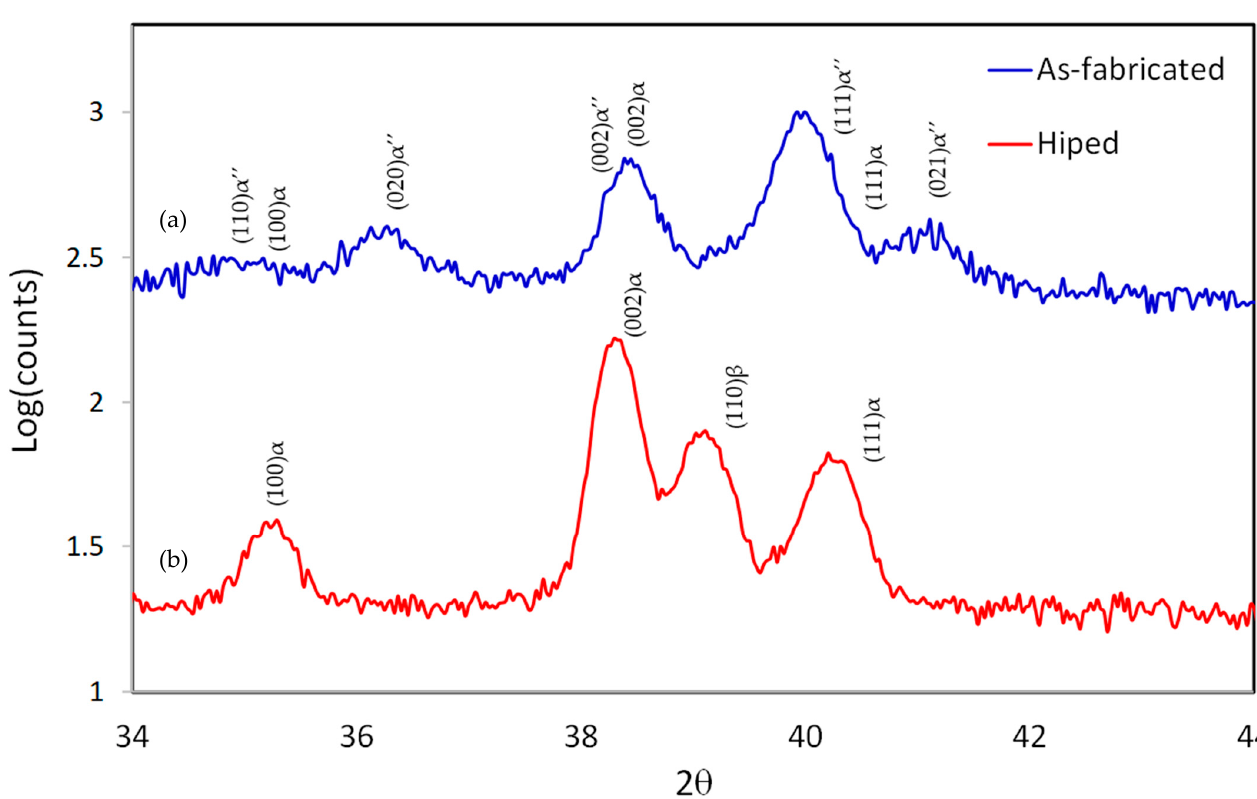
Figure 11. XRD results for samples fabricated using: ( a ) LPBF only; ( b ) LPBF followed by HIP process.